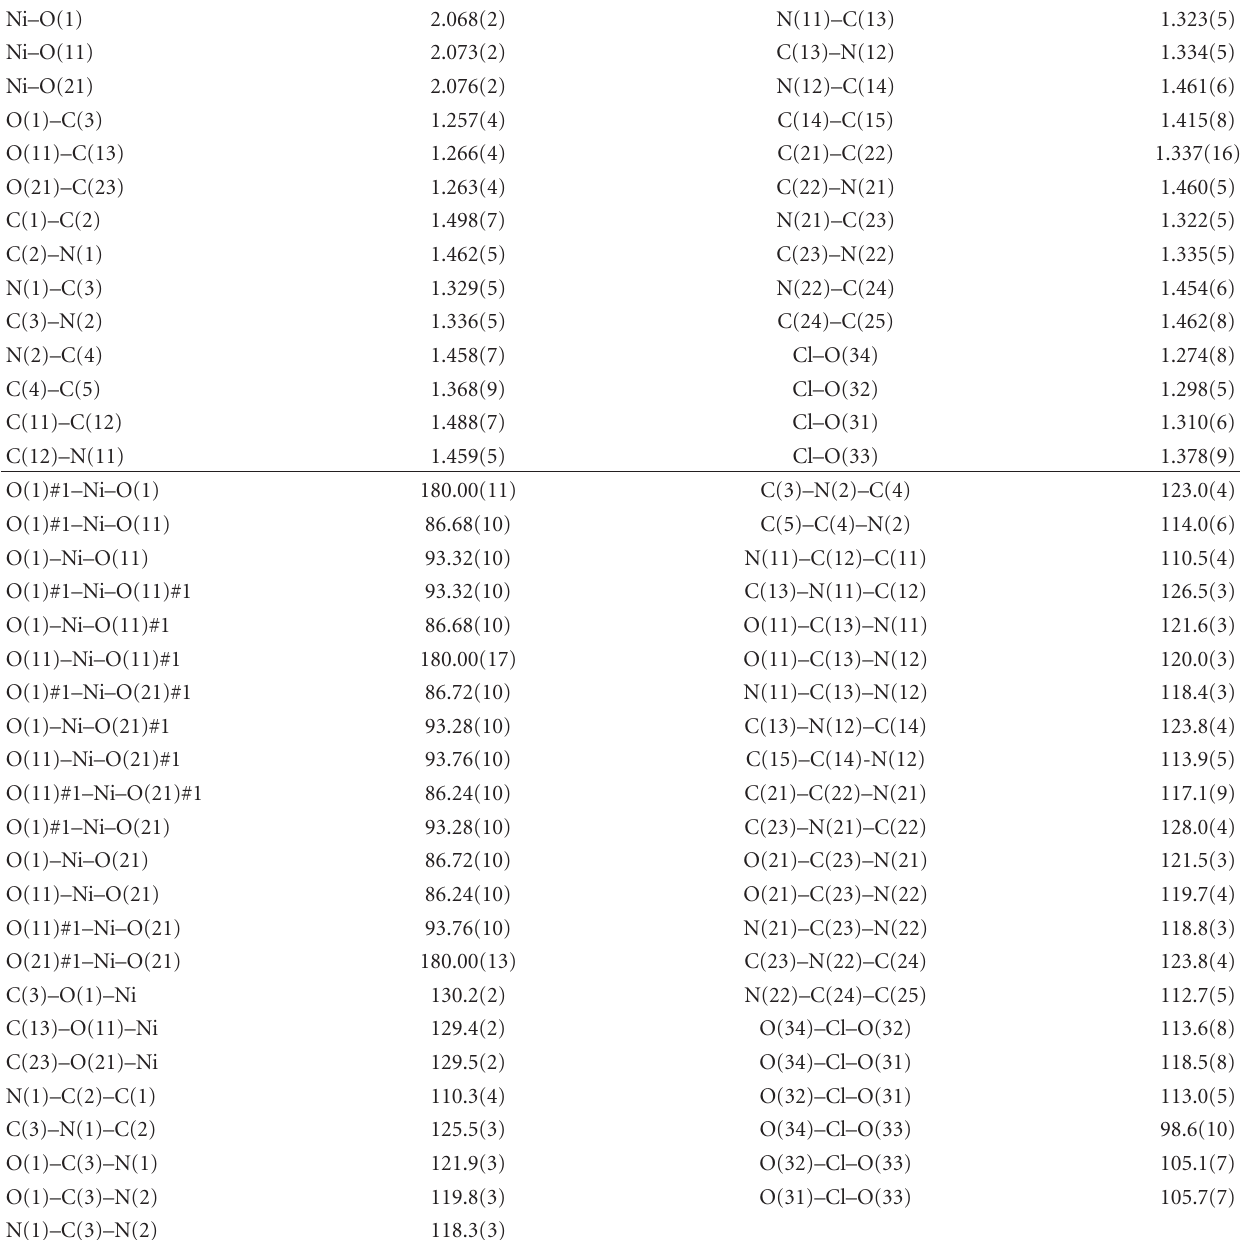
Table 4: Selected bond lengths (˚A) and angles ( ◦ ) for 3